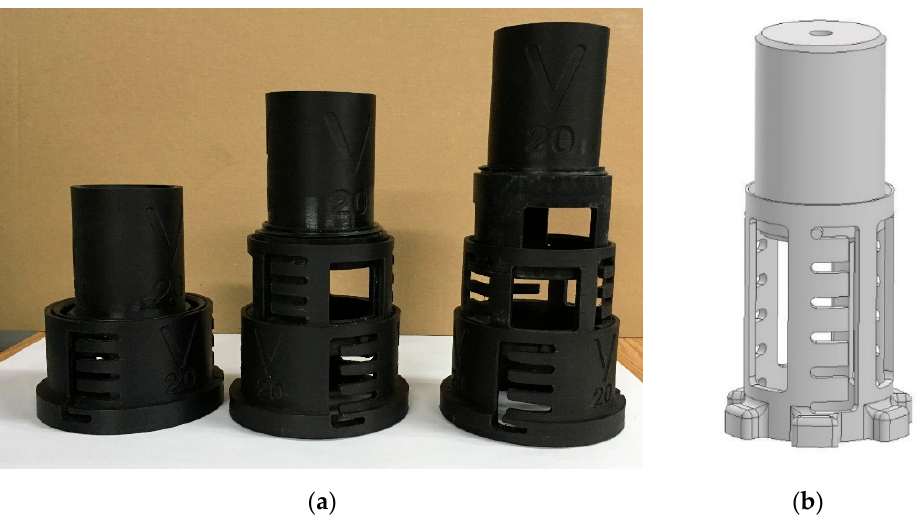
Figure 2. View of the structure of shaped charges: ( a ) first design of the shaped charge prototype and ( b ) final design of the shaped charge construction.